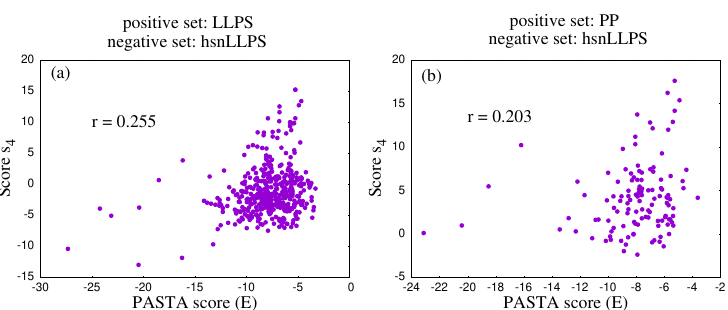
Figure 5. Correlation plot between the PASTA energy E and the score s 4 . Each point represents a sequence in the positive set. ( a ) LLPS positive set. ( b ) PP positive